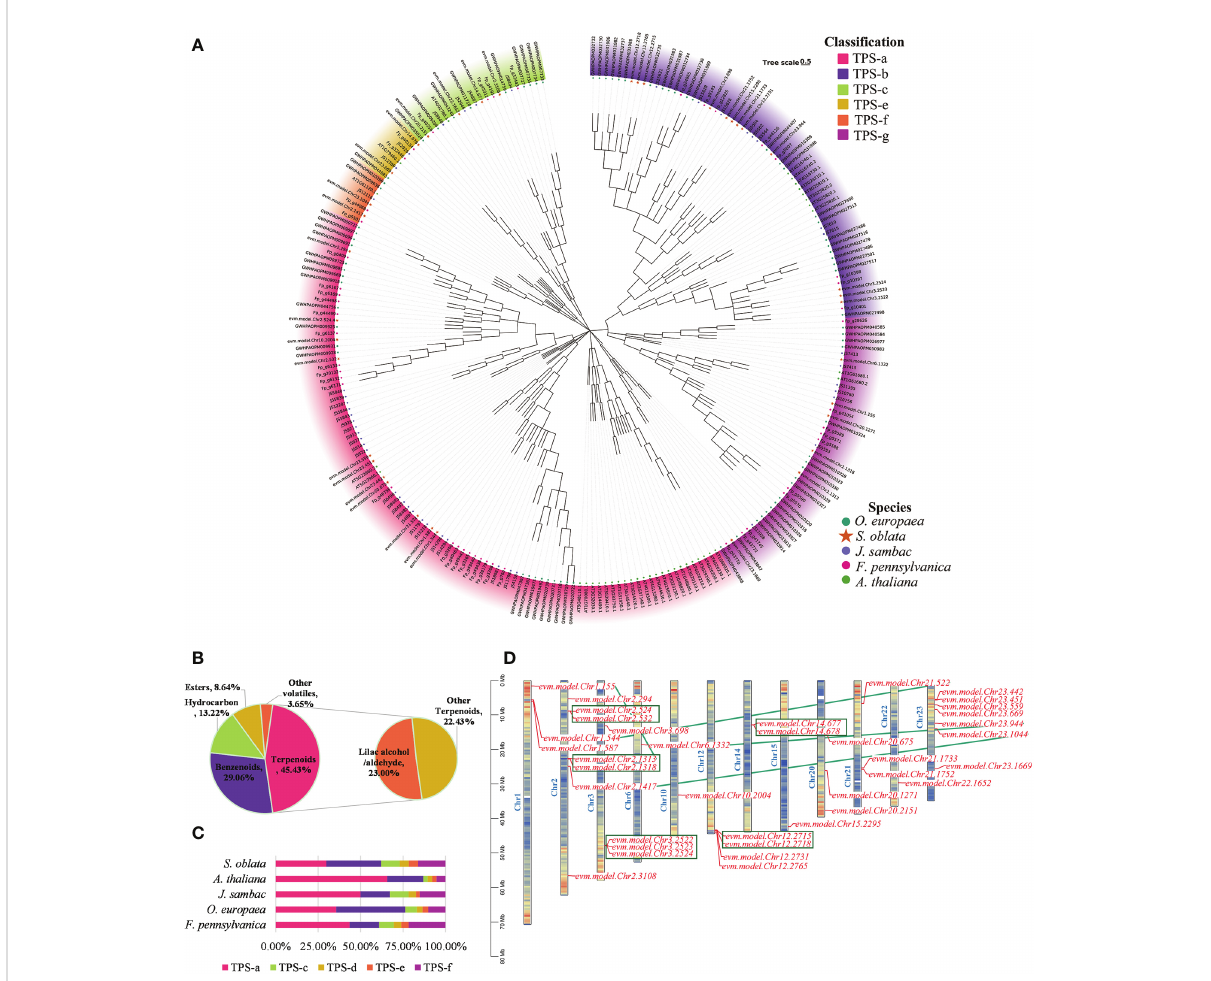
FIGURE 5 Analysis of molecular mechanism of biosynthesis of S. oblata fl ower volatiles. (A) Evolutionary trees of A. thaliana, J. sambac, O. europaea and F. pennsylvanica TPS genes. (B) The volatile components of S. oblata. (C) Percentage of TPS subgroups in different species. (D) Chromosome location map of TPS genes in S. oblata